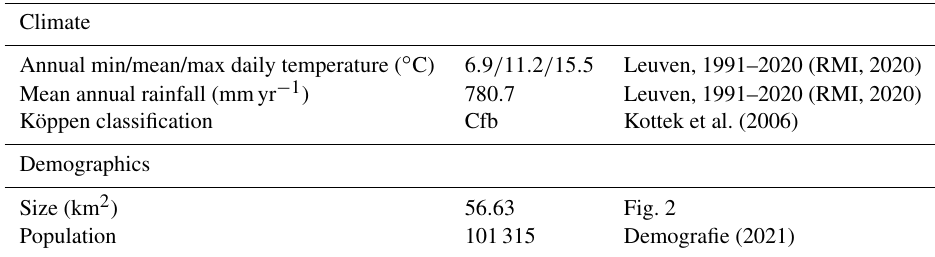
Table 1. Main characteristics of the study area Leuven.